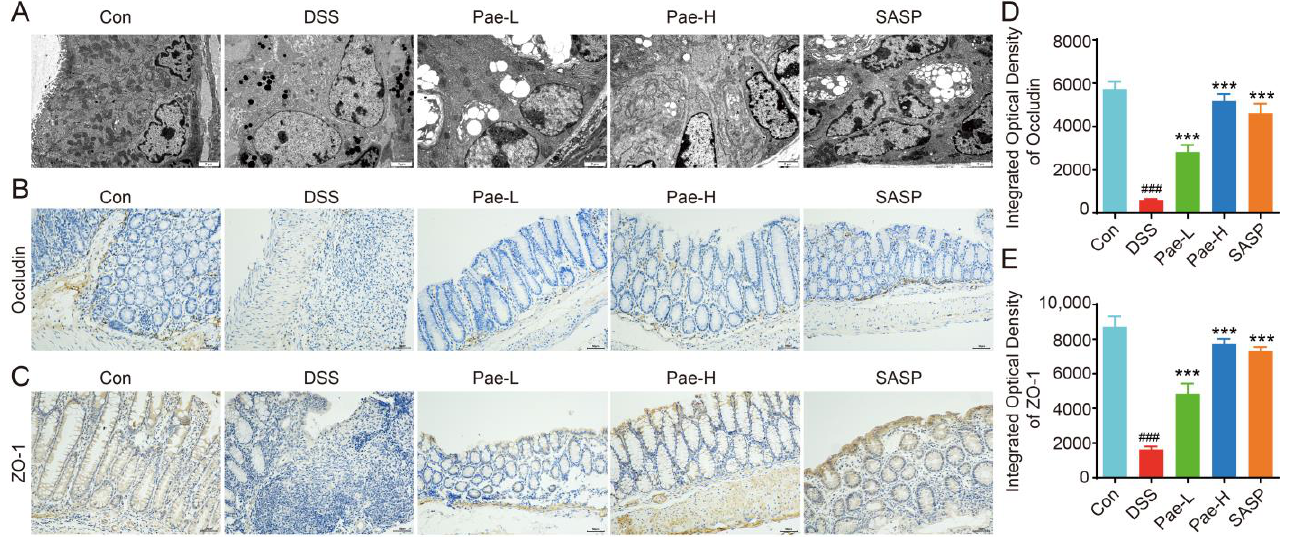
Figure 3. Pae restores intestinal barrier function in DSS-induced UC mice. ( A ) Representative images of colon tissue observed under a transmission electron microscopy (×10,000) ( n = 3). ( B and C ) Immunohistochemistry staining (scale bar, 50 mm) ( n = 5). ( D and E ) quantitative analysis of Occludin and ZO-1 protein content in the colon ( n = 5). Data are shown as mean ± sem. ### p < 0.001, compared with Con group, *** p < 0.001, compared with DSS group.